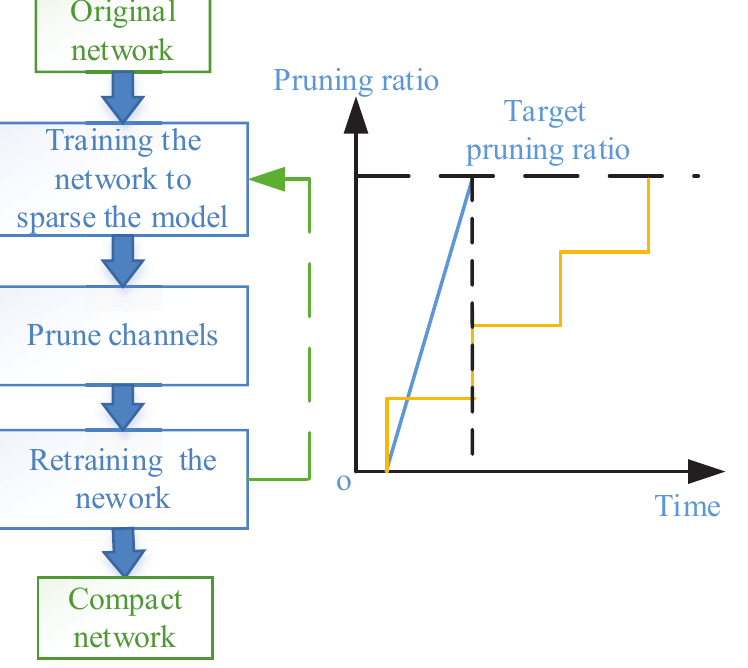
Figure 4. Left: Flowchart of different pruning methods, the dotted-line represents iterative pruning. Right: The blue line represents the One-shot Pruning method and the yellow line represents the Iterative Pruning